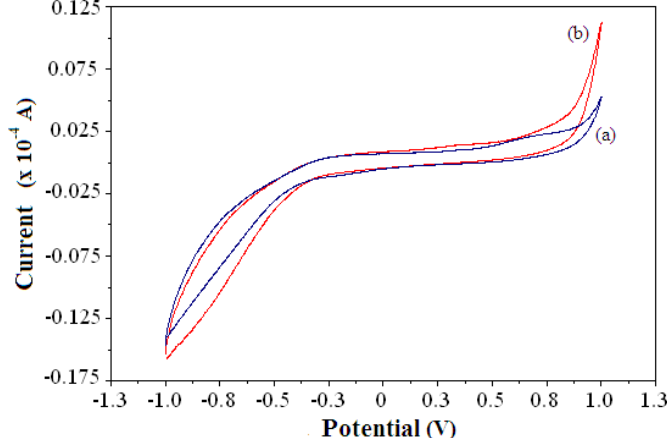
Figure 2. Cyclic voltammograms of NH 4+ ion biosensor in the absence ( a ) and